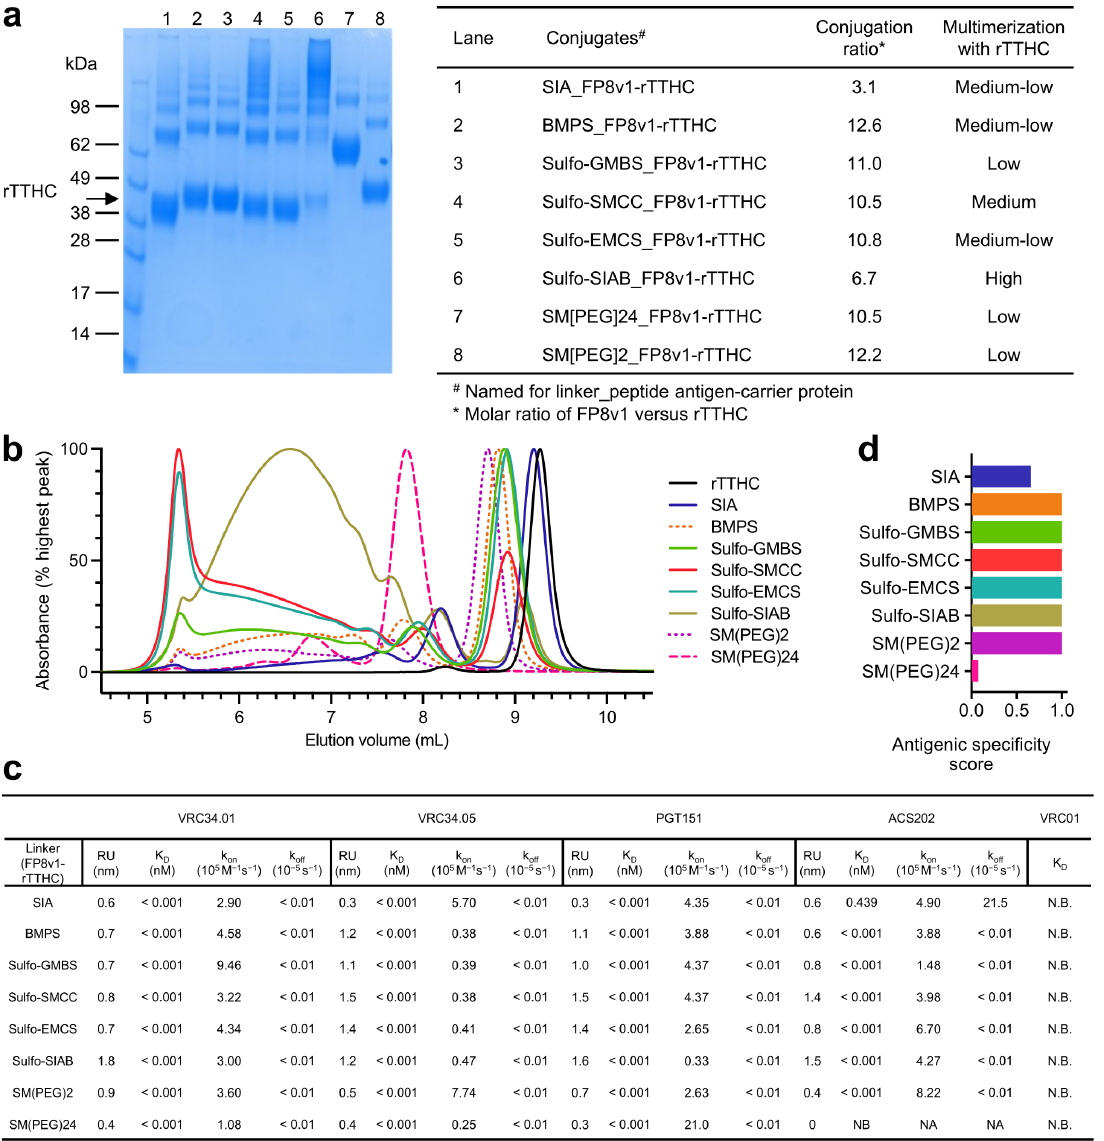
Figure 2. Physical and antigenic properties of FP8v1-rTTHC conjugates with linkers of various spacer-arm length. ( a ) SDS-PAGE of the purified FP8v1-rTTHC conjugates of eight different linkers revealing variable degrees of multimerization. ( b ) Analytical SEC of FP8v1 peptide conjugates. ( c ) Antigenicity characterization of FP8v1-rTTHC conjugates of eight different linkers by BLI measurements of their binding affinity to FP-directed antibodies. ( d) Antigenic specific score as defined in [5].